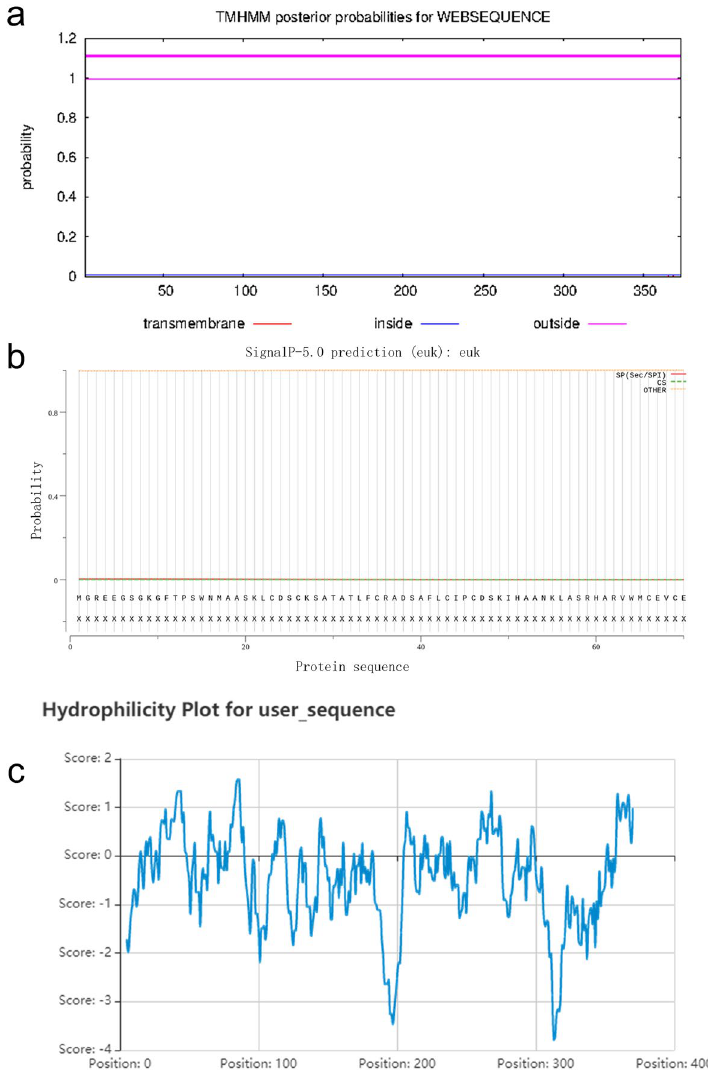
Figure 5. Bioinformational analysis of PlCO protein. ( a ) Trans-membrane prediction of PlCO; ( b ) signal peptide predicton of PlCO; ( c ) hydrophilicity prediction of